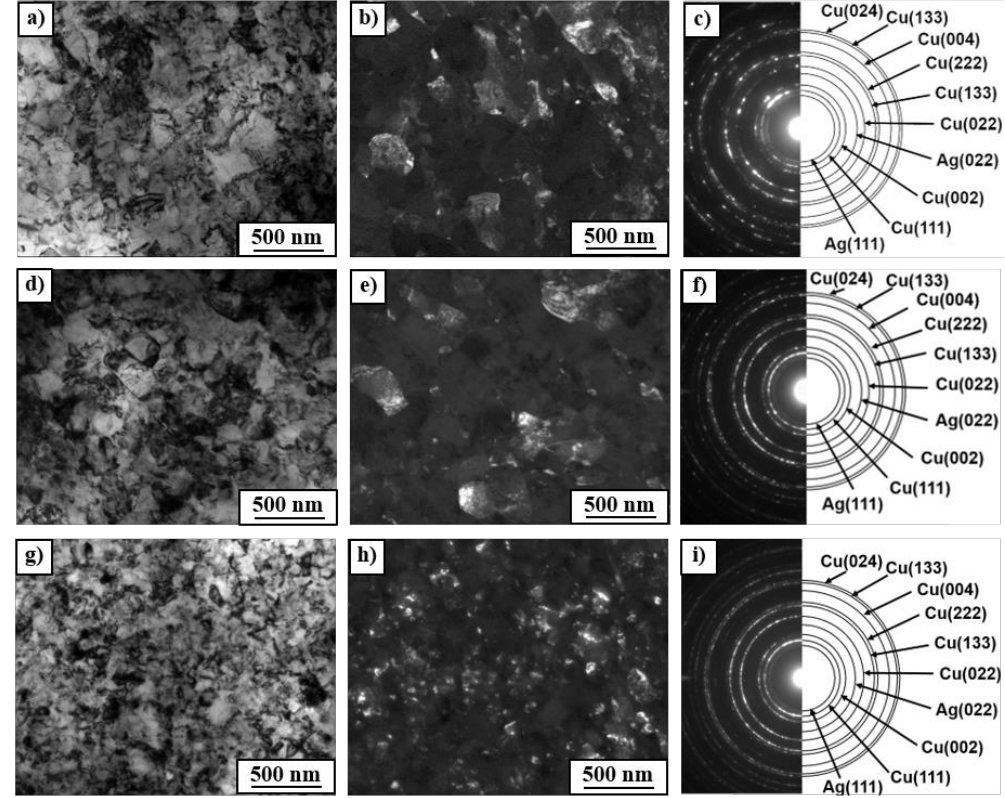
Figure 4. TEM images of the Cu–8wt.%Ag alloy after annealing and HPT: ( a – c ) 400 °C + HPT; ( d – f ) 500 °C + HPT; ( g – i ) 600 °C + HPT; ( a , d , g ) bright field images; ( b , e , h ) dark field images; ( c , f , i ) SAED